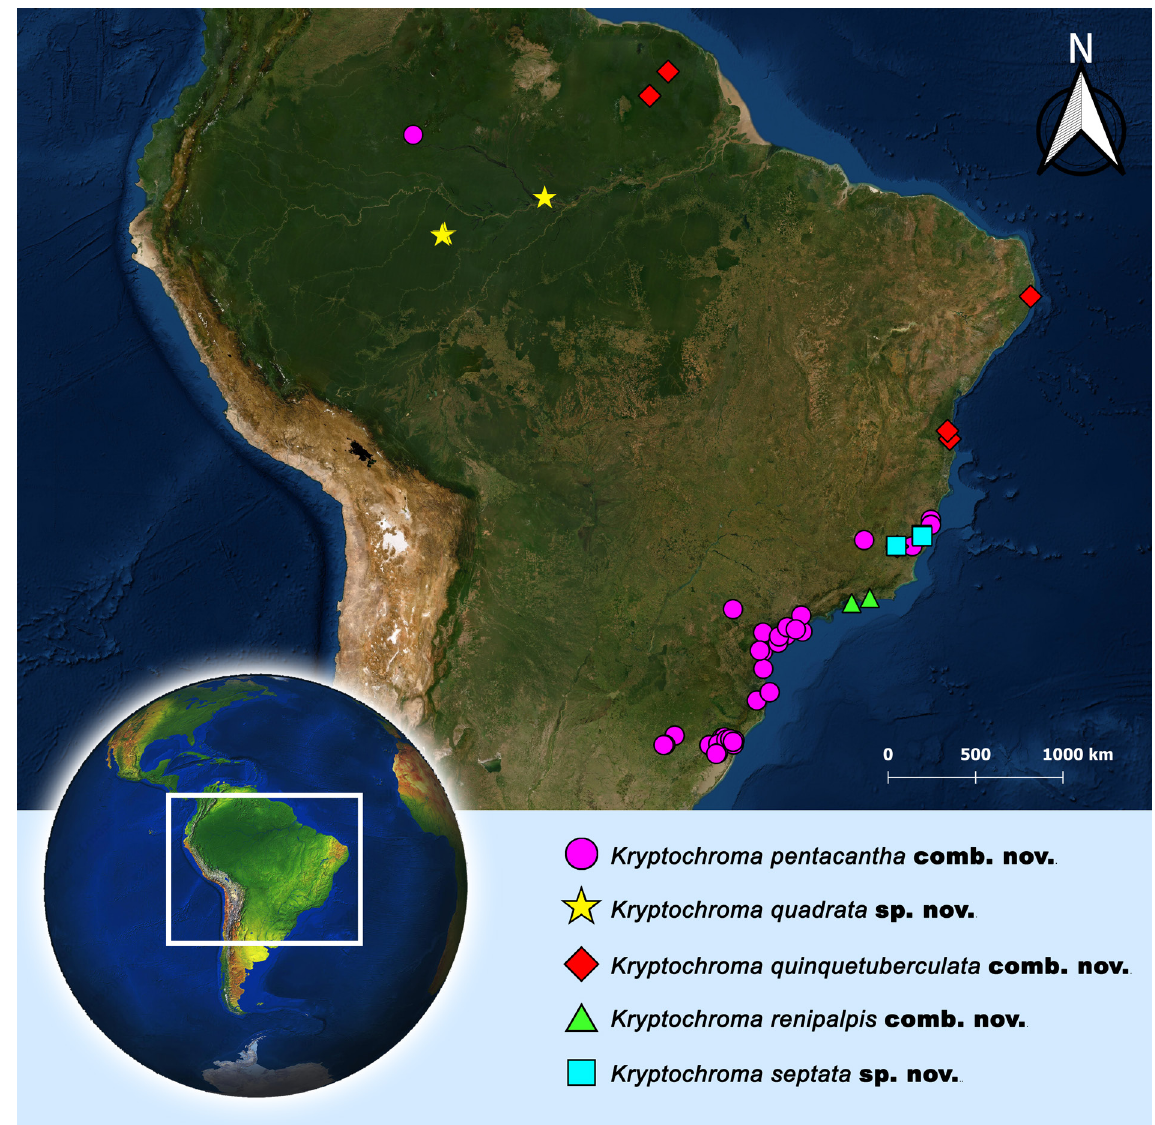
Fig. 18. Distribution records of species of Kryptochroma Machado gen.